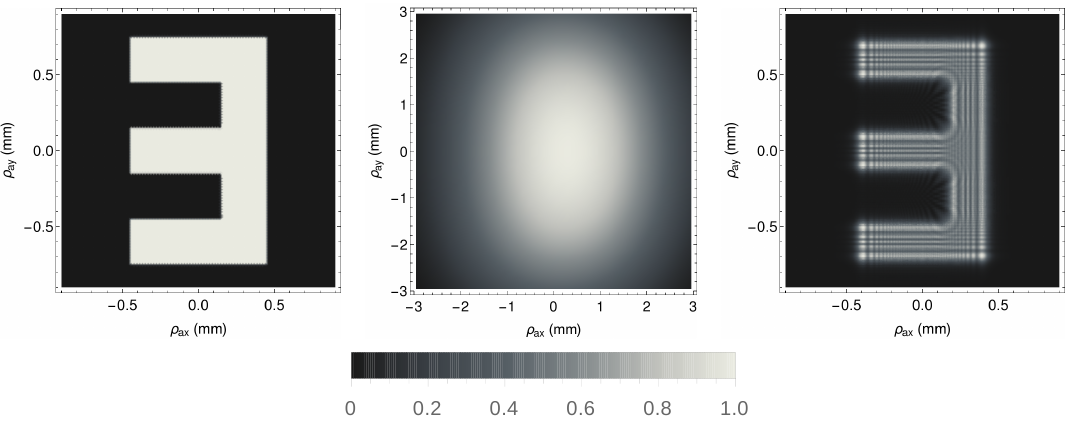
Figure 3. Comparison between focused (left), misfocused (center) and refocused (right) images of a two-dimensional object. Intensities are normalized to their maximum value in all panels. The out-of-focus and the refocused images are taken in the same setup, in which z b ≈ z bF /3.